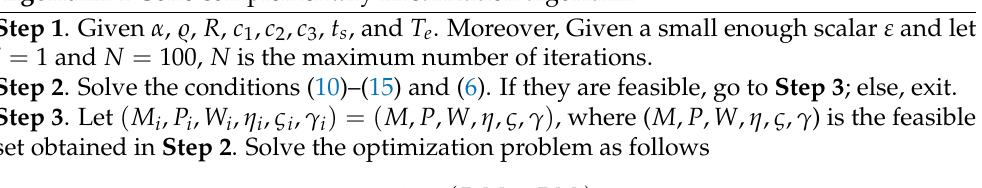
Algorithm 1 Cone complementary linearization